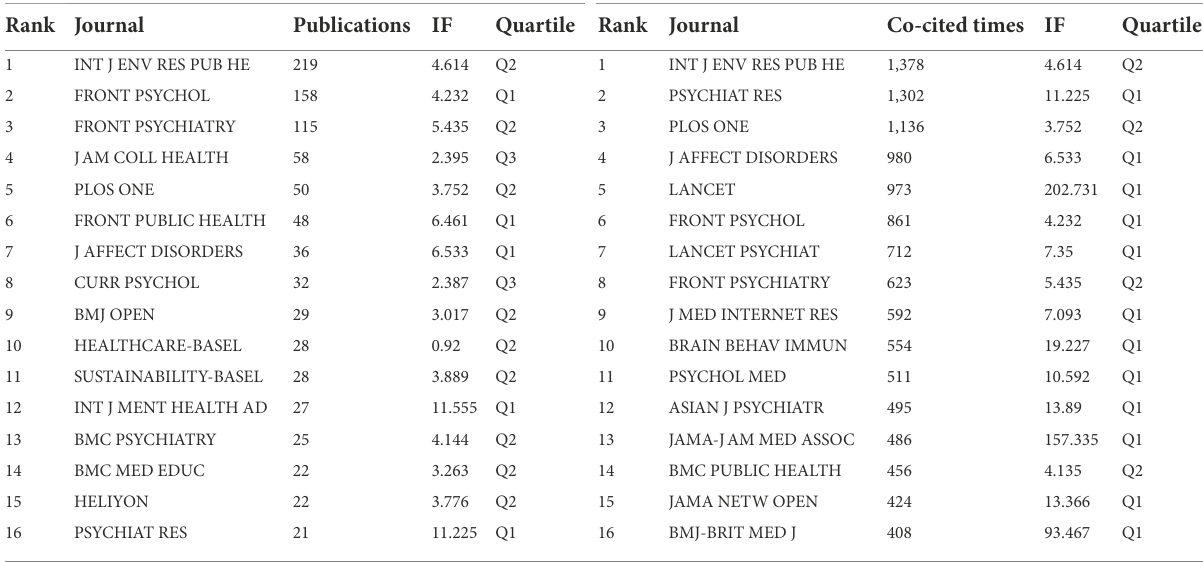
TABLE 5 Core journals related to the research of mental health of students during